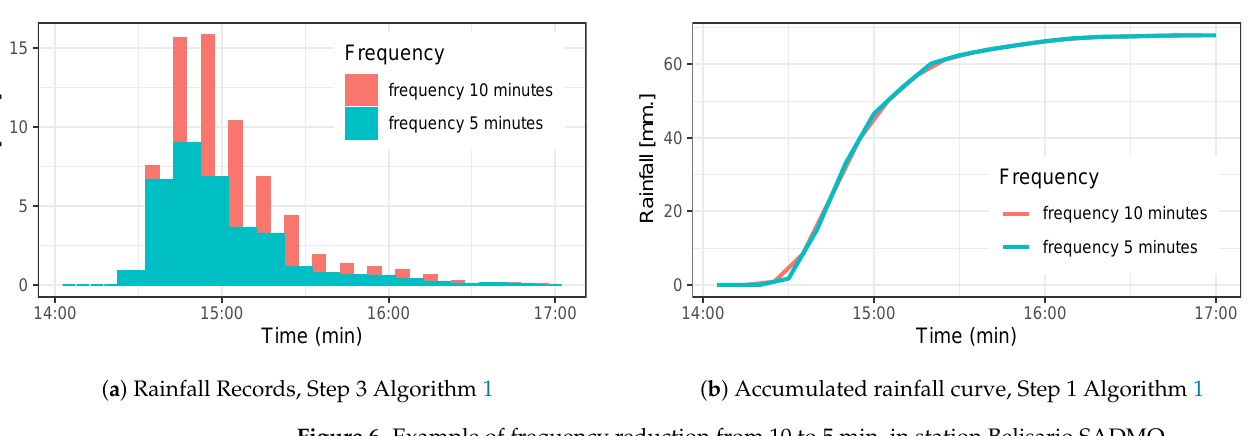
Figure 5. Records before and after of data validation, Station P09. Extremely high isolated records were eliminated.